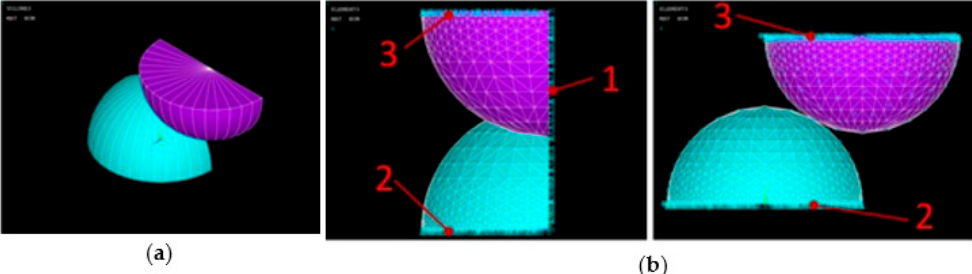
Figure 11. ( a ) Model composed of fixed hemisphere made of steel and of moving hemisphere made of polyoxymethylene; ( b ) Mesh of finite elements and boundary conditions.